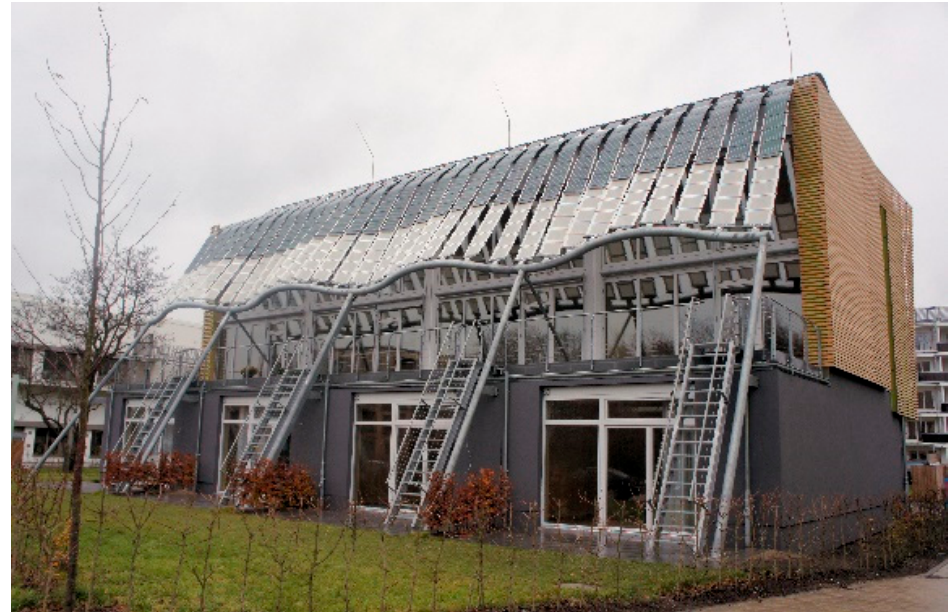
Figure 11. Solar electricity generating thin-film system independent of the building (photo by W. Celadyn).